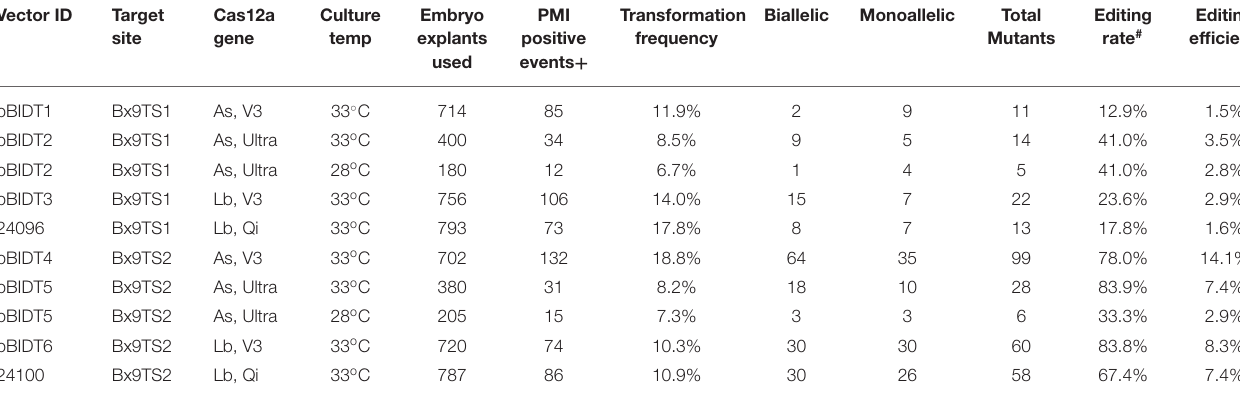
TABLE 5 | Editing efficiency of Bx9 target sequences in transgenic plants expressing different versions of Cas12a enzymes. Vector